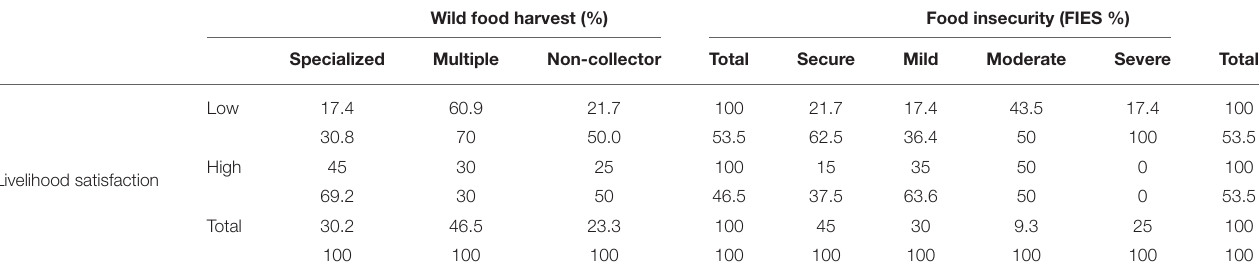
TABLE 3 | Livelihood satisfaction by wild food harvest and